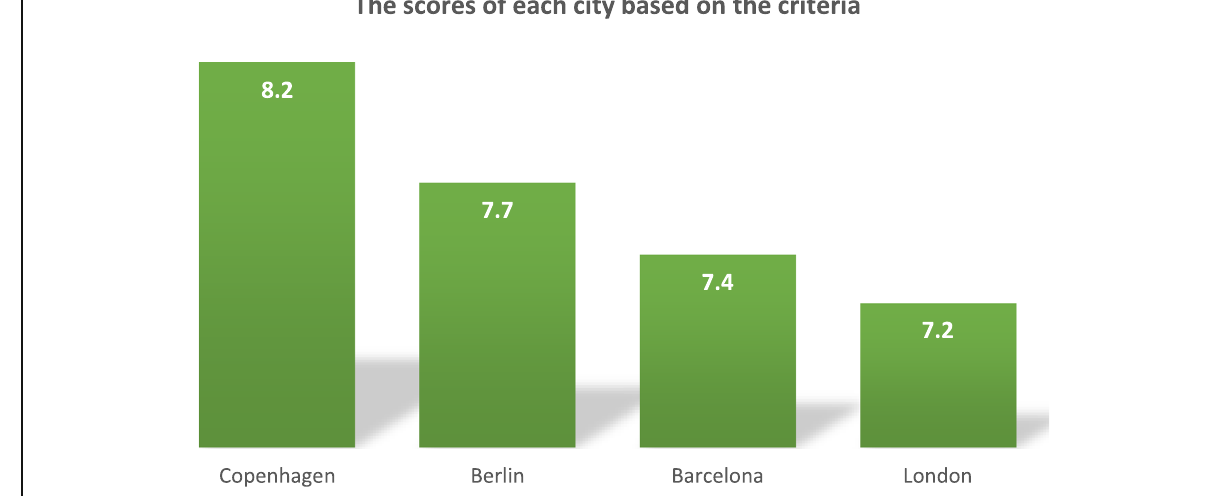
Fig. 4 The scores of each city based on the criteria. Source “ by the author